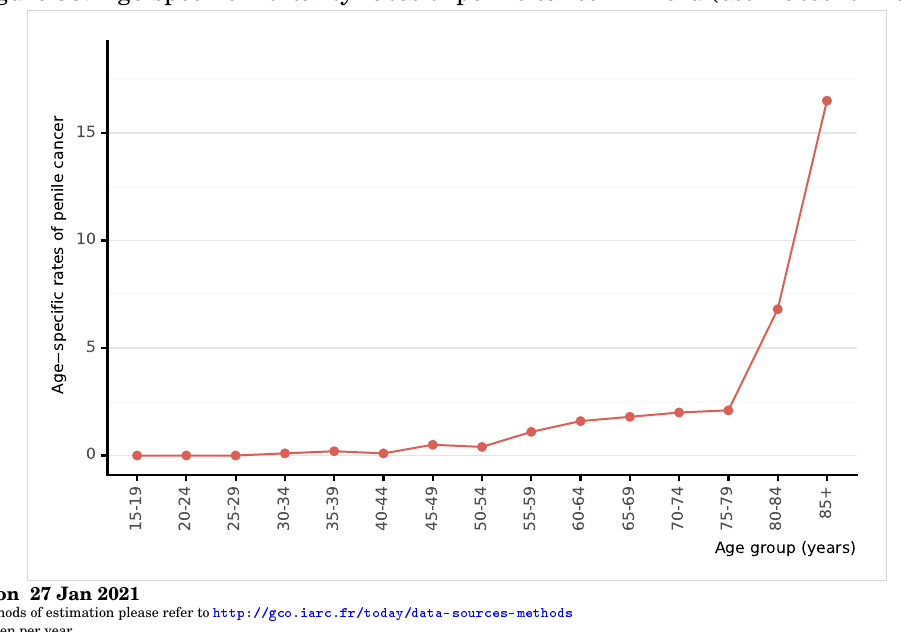
Figure 33: Age-specific mortality rates of penile cancer in Peru (estimates for 2020)